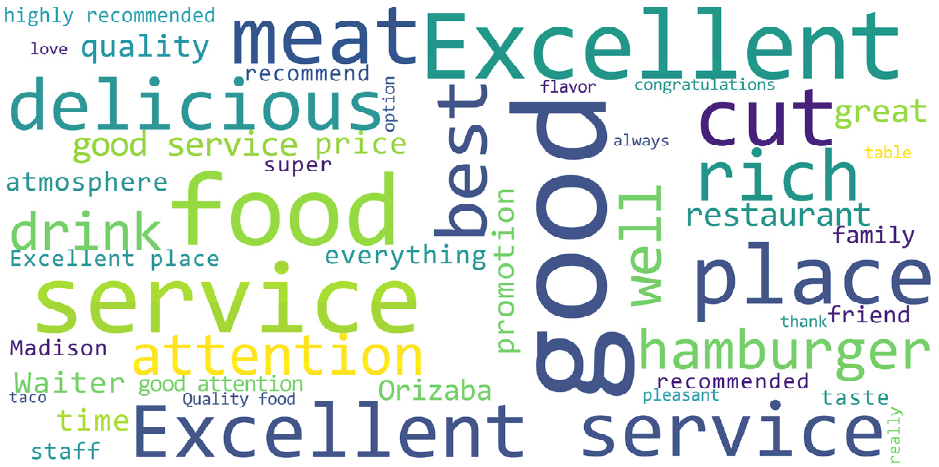
Figure 6. A word cloud illustrating the most frequent tokens, the final processed dataset. Each comment was oriented to a specific KPI of interest (KPI 1 -KPI 9 ) previously val- idated by the planning team. Using Python, the Jaccard similarity index (Equation (5)) was used to determine the relationship between the intersection referring to the set of tokens present in the opinions and the set of tokens present in the KPIs. The union between the two sets was analyzed. Jaccard distance (Equation (6)), used in the Python code as jaccard_distance = 1—jaccard_similarity, was used to calculate the distance of the tokens present in the comments to the KPIs and categorize each of the BSC perspectives. The planning team validated the KPIs and their orientations to each perspective using an affinity diagram. Figure 7 shows a representation of the BSC architecture, which was automatically generated according to valuable information from customer